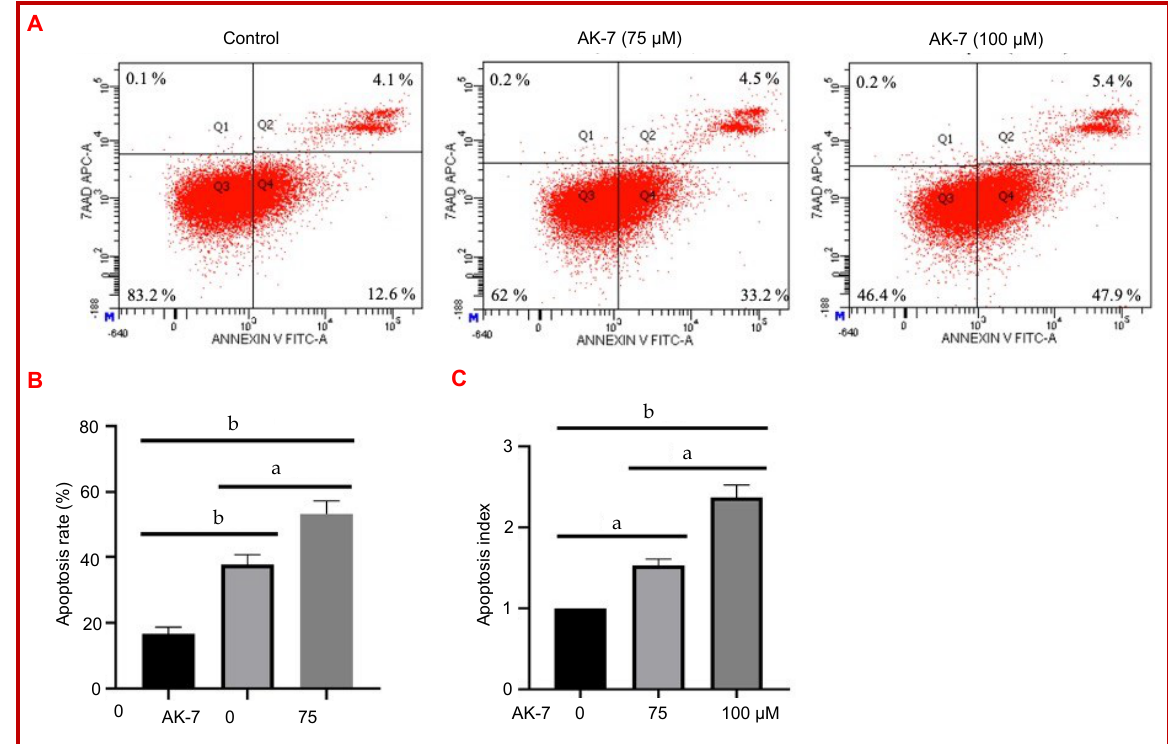
Figure 2: AK-7 promoted apoptosis of U87 glioblastoma multiforme cells. U87 cells were treated with two different concentrations (75 and 100 μ M) of AK-7 for 48 hours. After treatment, annexin V/7-AAD analysis was performed to determine the necrotic, early and late apoptotic cells in each group (A-B). Apoptotic cell death due to DNA fragmentation was evaluated using a cell death detection ELISA PLUS kit ( a p<0.01, b p<0.001)